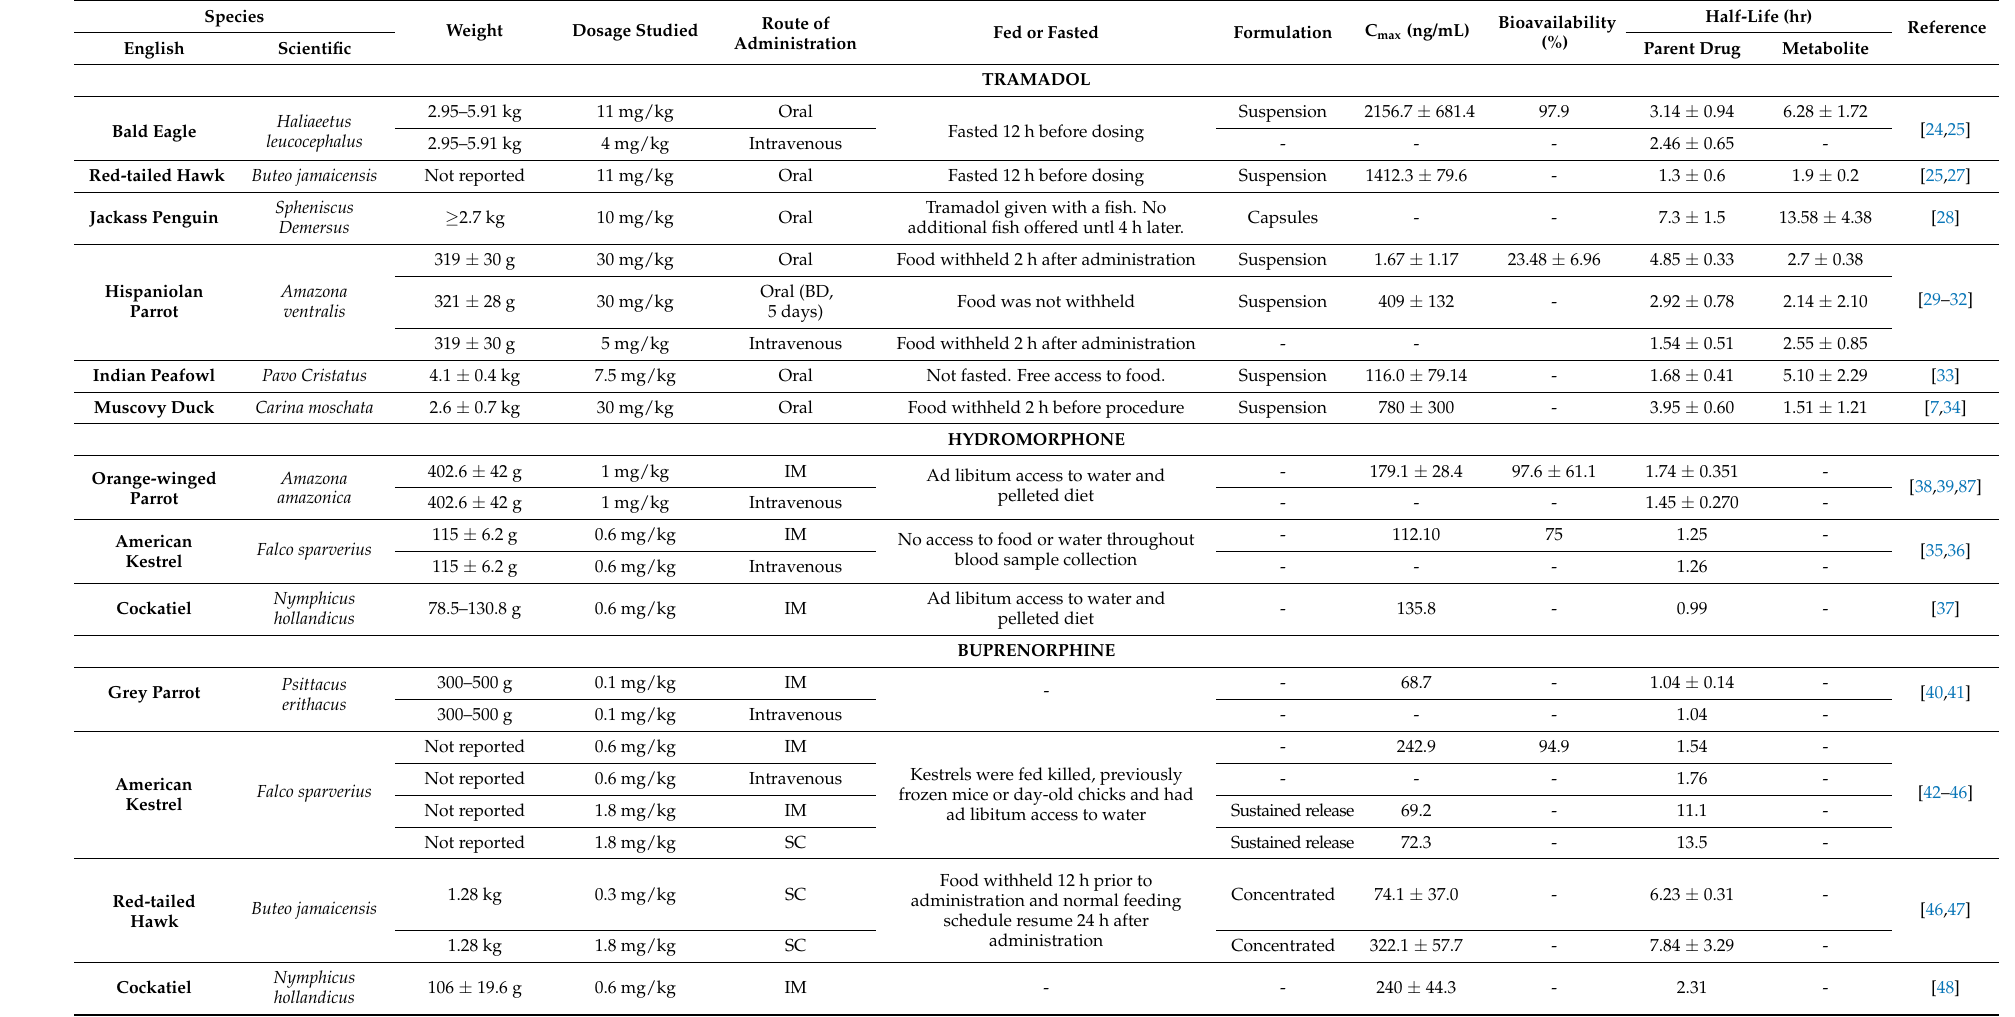
Table 5. The reported half-lives of selected opioids in avian species